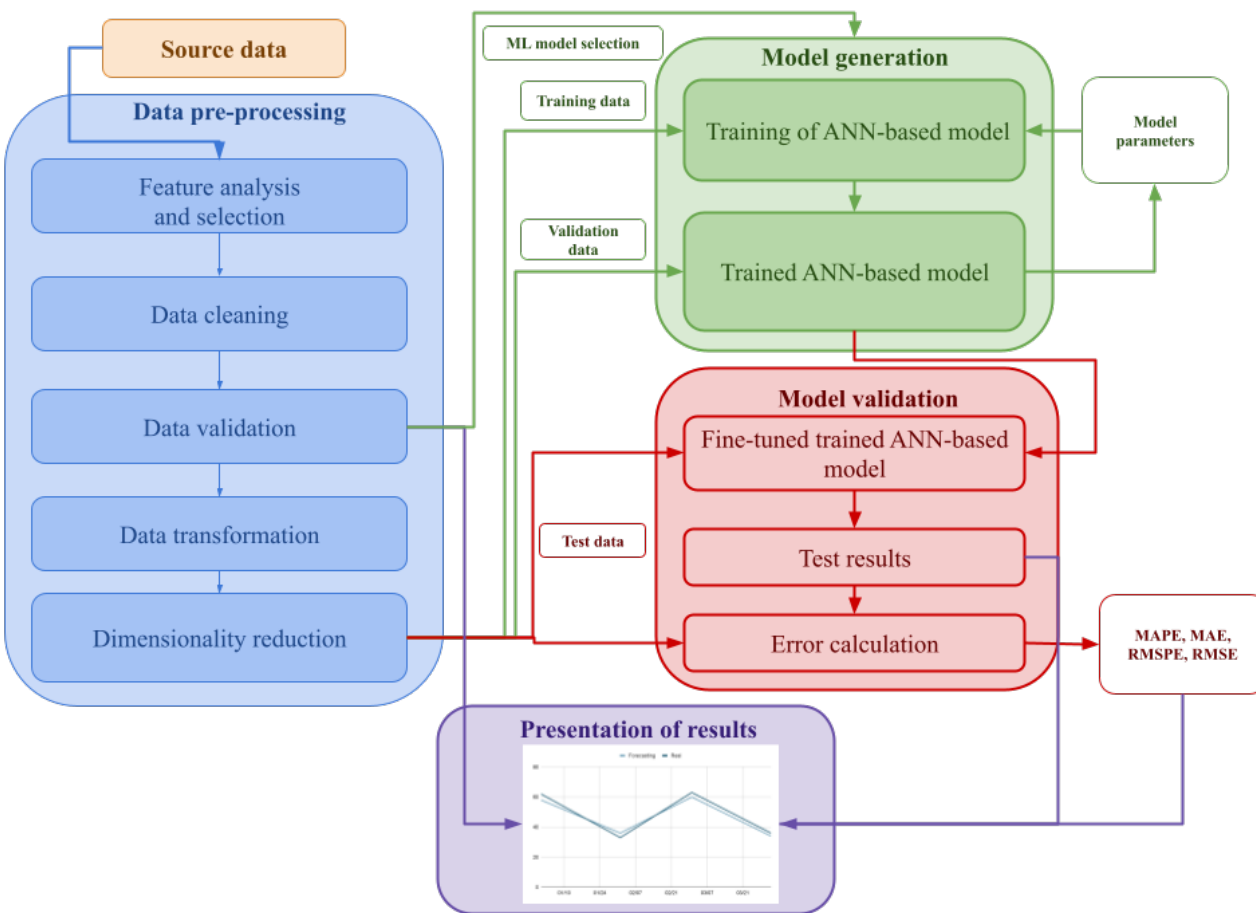
Figure 1. Generalization of the steps documented in the reviewed